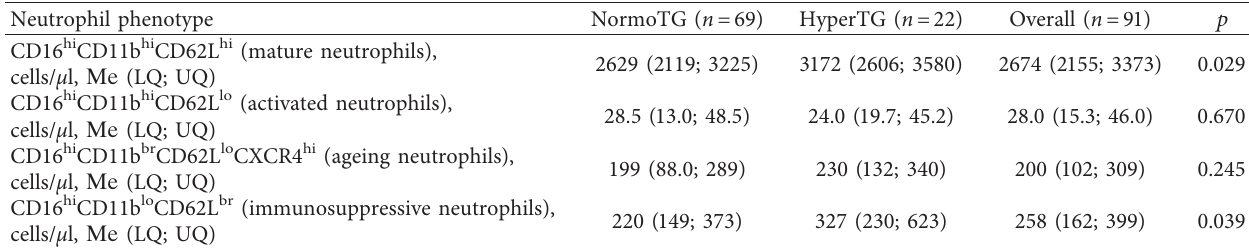
Table 2: Subpopulations of circulating